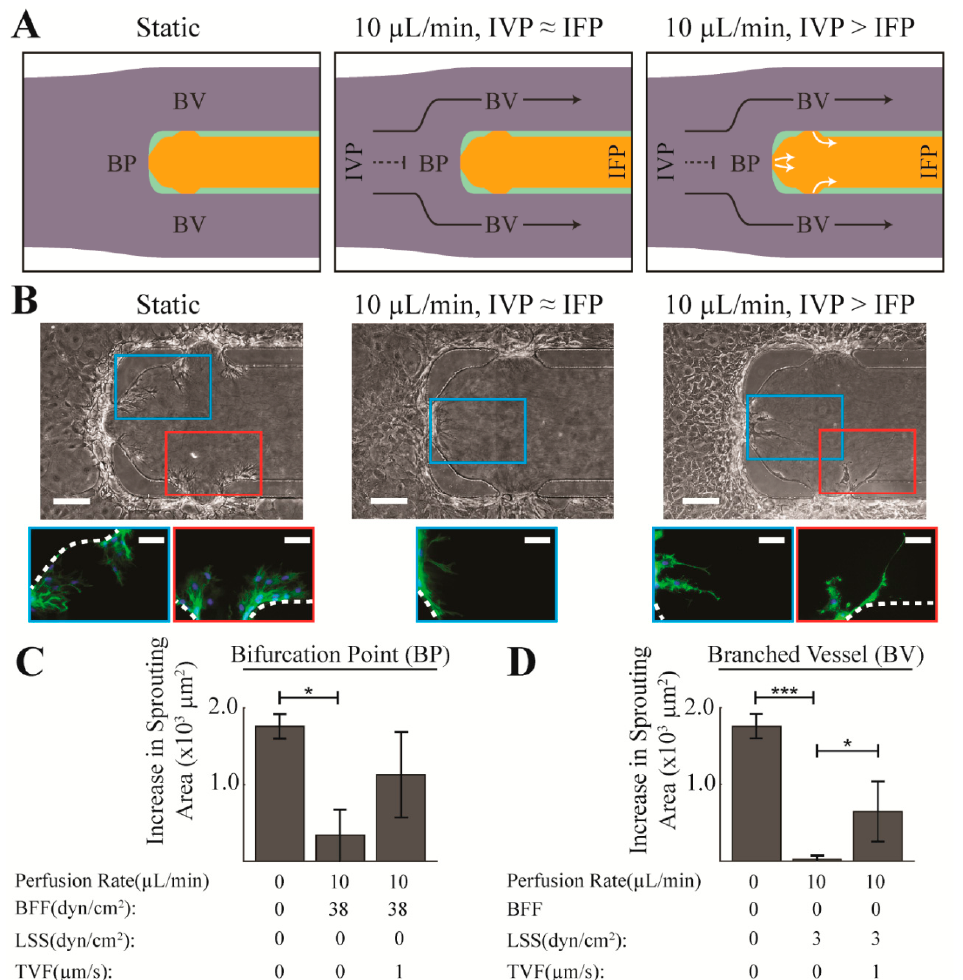
Figure 2. Application of bifurcating fluid flow (BFF) and laminar shear stress (LSS) attenuated endothelial sprouting. ( A ) The top-view schematics of the microdevice depicting the fluid mechanical factors under: (i) static, (ii) perfusion with equilibrated IVP and IFP resulting in BFF (dashed black line) at the BP, LSS (solid black line) in each BV and negligible transvascular flow (TVF), and (iii) perfusion with elevated IVP resulting in BFF at the BP, LSS in each BV and 1 µm/s TVF (white solid lines). ( B ) Representative phase contrast and epifluorescence images of sprouting MAECs in response to perfusion with ~10 µL/min after 48 h under equilibrated and elevated IVP compared to static control condition. Dashed white lines mark the location of the polydimethylsiloxane (PDMS) posts. ( C , D ) Quantitative representation of the level of increase in sprouting area in response to treatment with each experimental test condition: at the BP, and in BV. *: p_value < 0.05 . ***: p_value < 0.001.